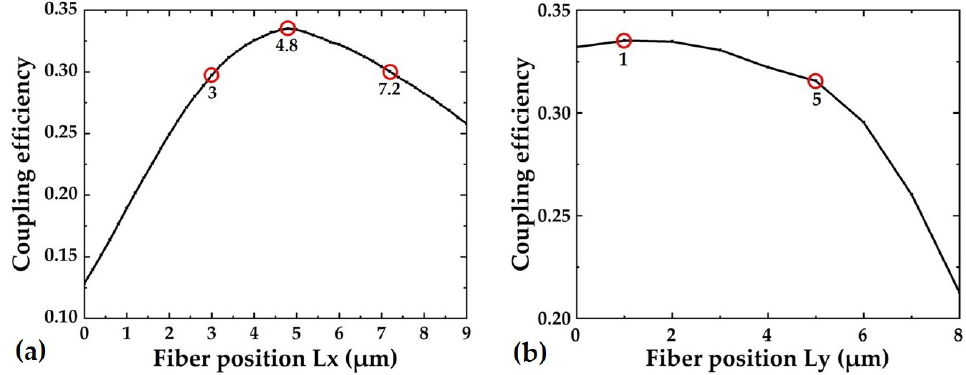
Figure 6. ( a ) Coupling efficiency as a function of Lx . ( b ) Coupling efficiency as a function of Ly .